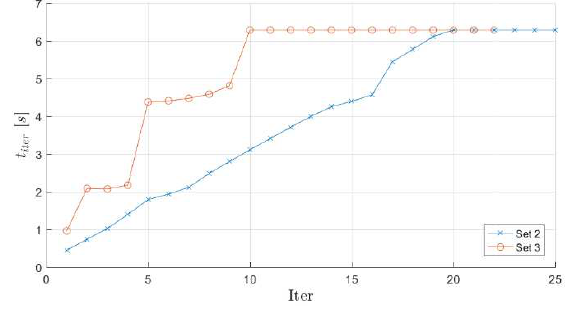
Figure 15. Iteration duration time